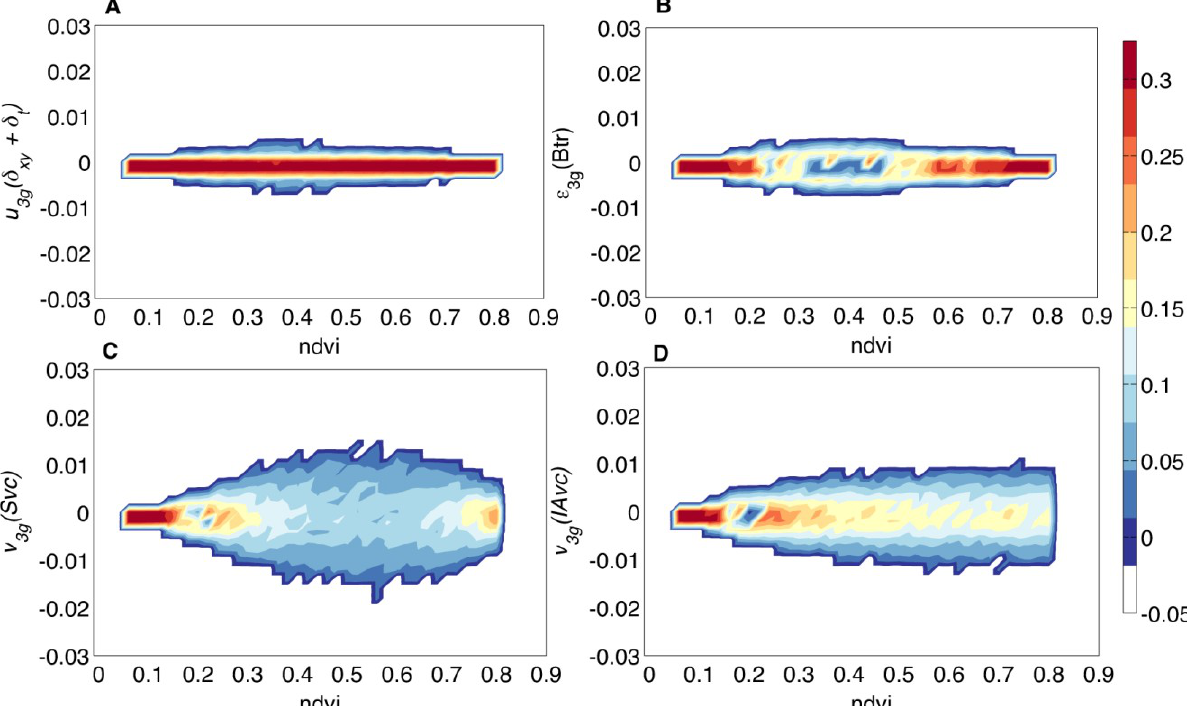
dynamical 3g + δ ); ( B ) the Bayesian transformation (Bt ); xy t r